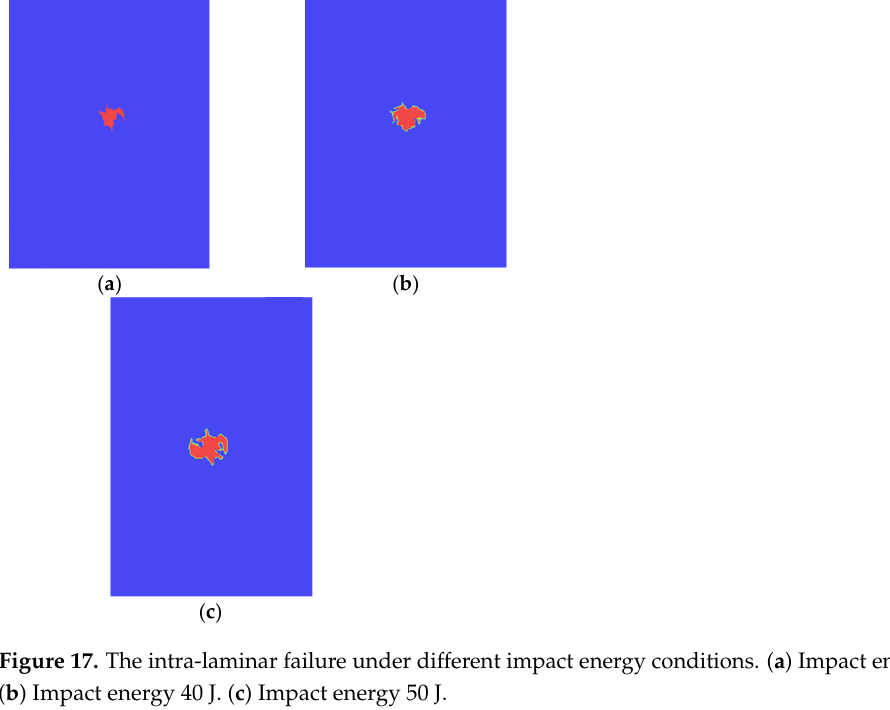
Figure 16. Variation of impactor energy and energy absorption. ( a ) Impactor energy curve. ( b ) Energy absorbed by composite laminate.